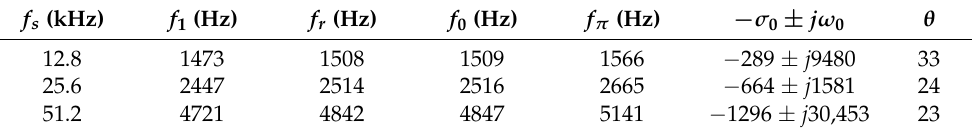
Table 2. Characteristic frequencies and closed-loop roots in the no-load mode.